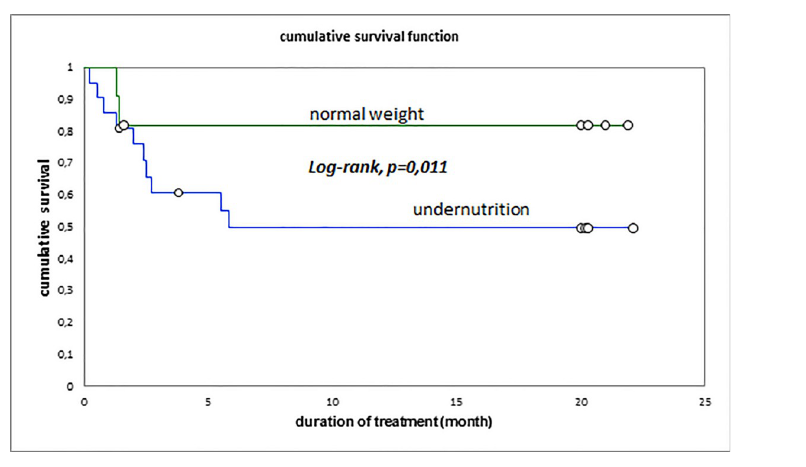
Fig 5. Survival by nutritional